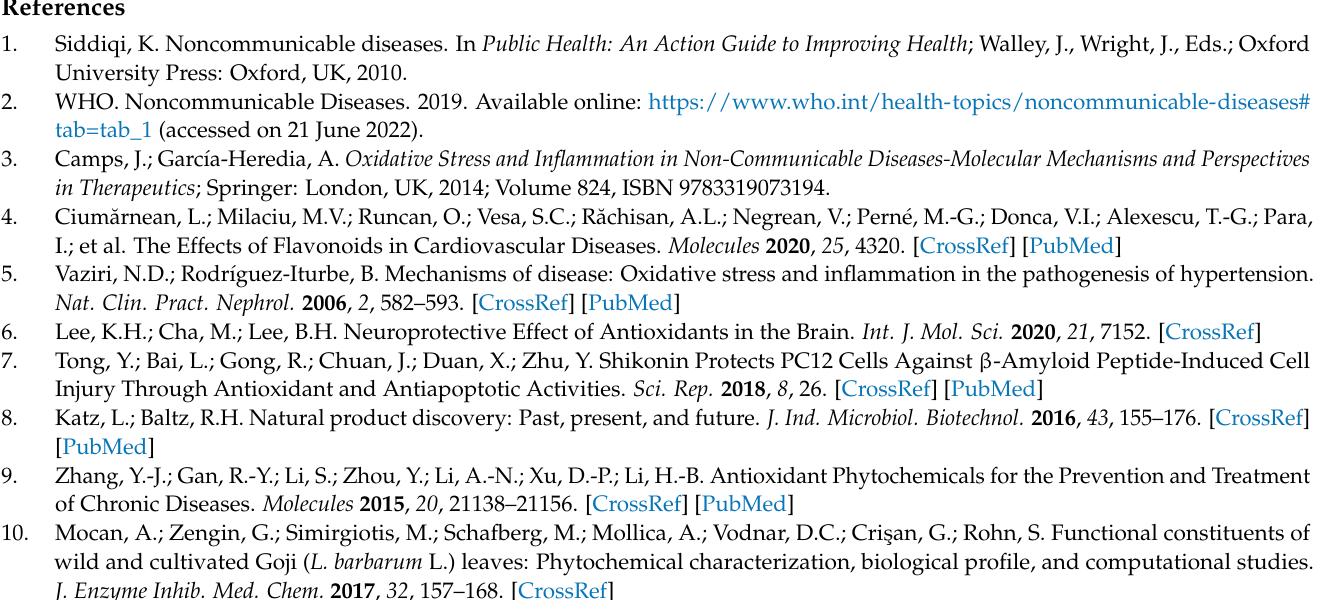
Figure S5: 1H NMR experiment for compound 2 , Figure S6: 13C NMR experiment for compound 2 , Figure S7: DEPT 13C NMR experiment for compound 2 , Figure S8: Molecular structure of the 2-nor-1,2-secolycoserone and ent-labda-8,13-E-diene-15-ol, Table S1: 1H NMR (500 MHz, CDCl 3